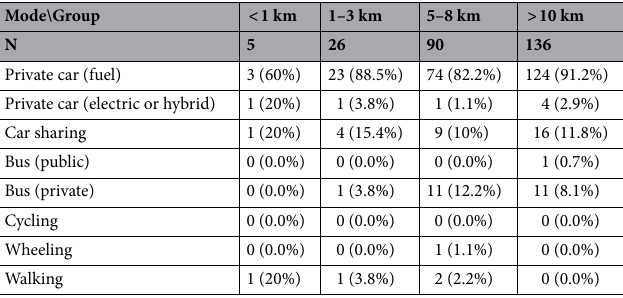
Table 6. Principal transportation modes by traveling distance.